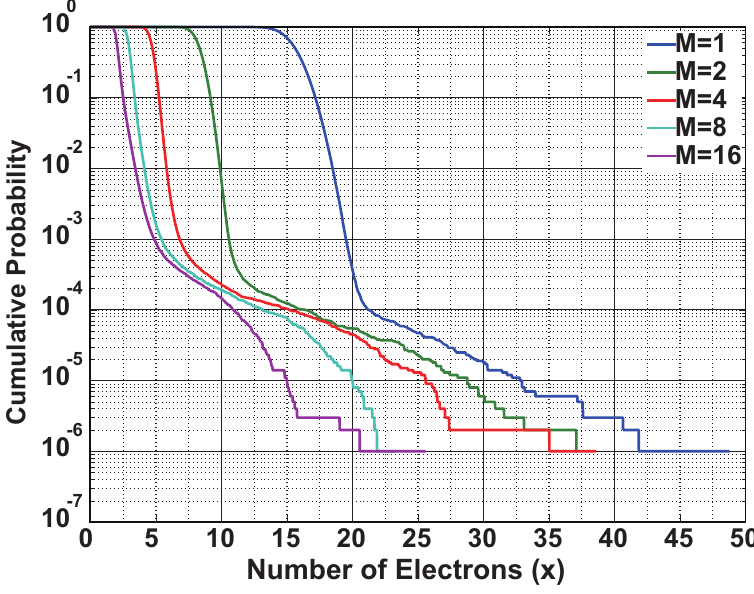
Figure 11. Cumulative Probability in SI-CMS